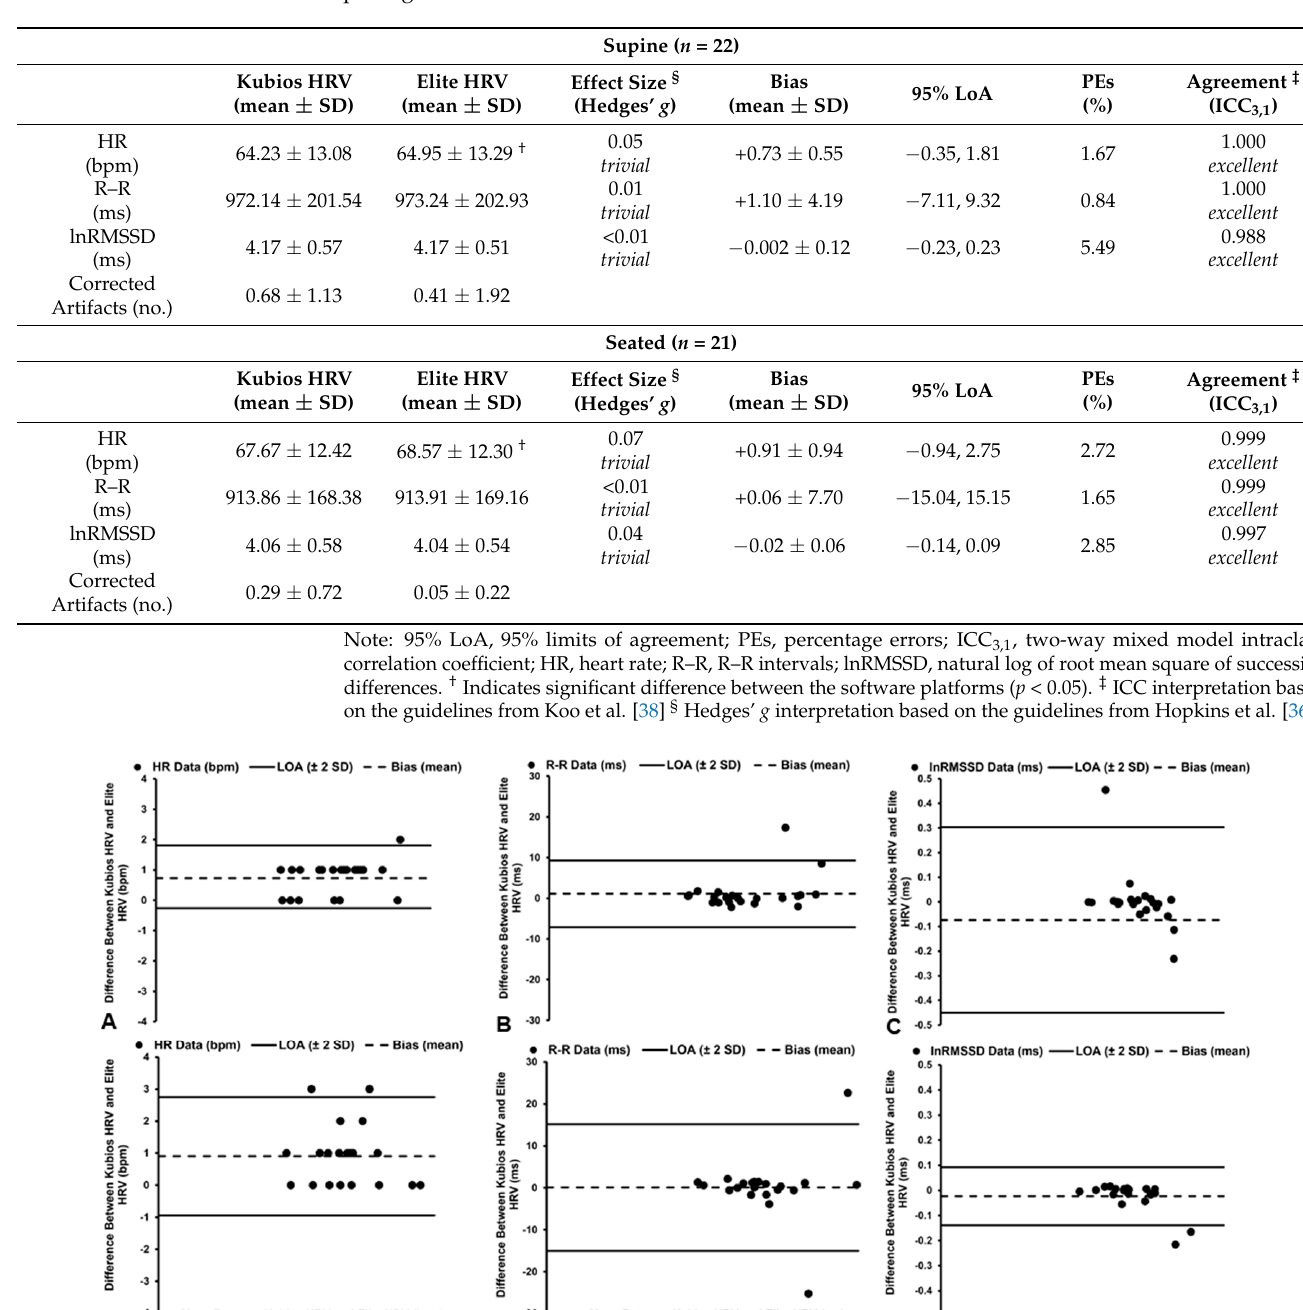
Table 4. Automatic Correction—Descriptive data, bias, error, and agreement between software packages.